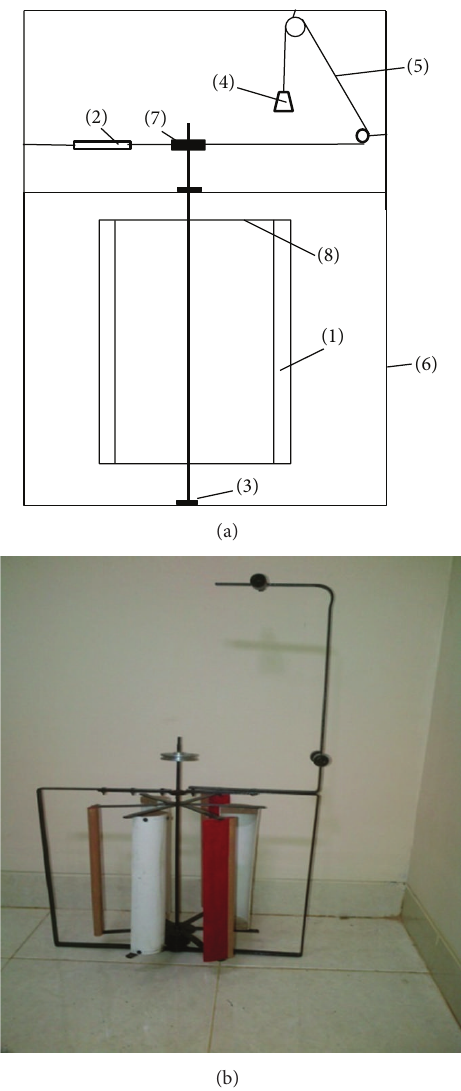
Figure 2: (a) Schematic diagram of the test setup, (b) experimental setup.